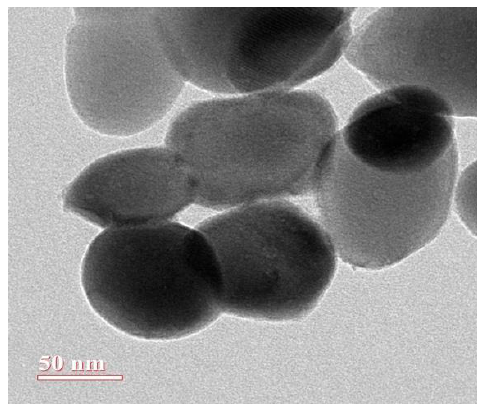
Figure 5. TEM image of synthesised AgNPs.